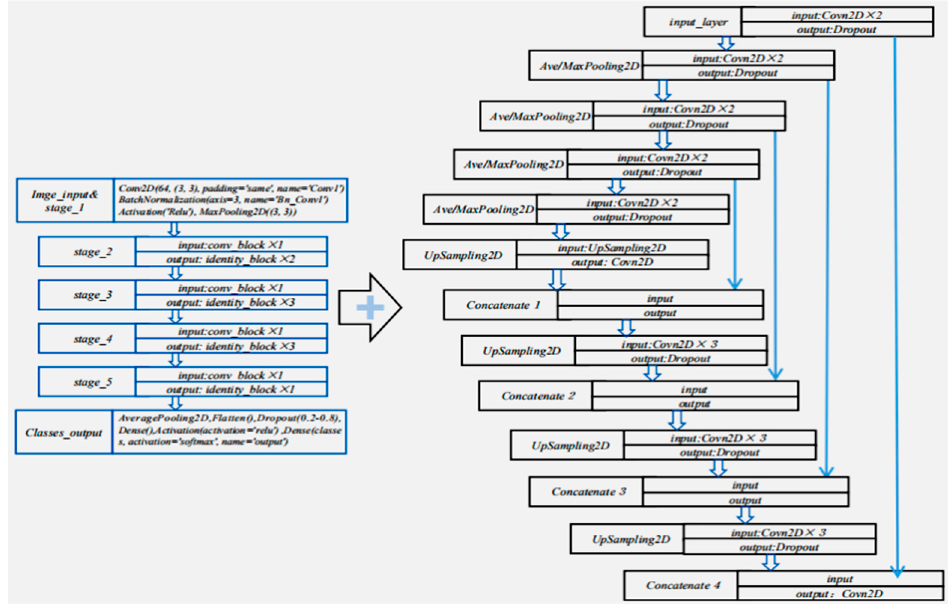
Figure 9. The schematic network architectures for defects recognition and ROI delineation.